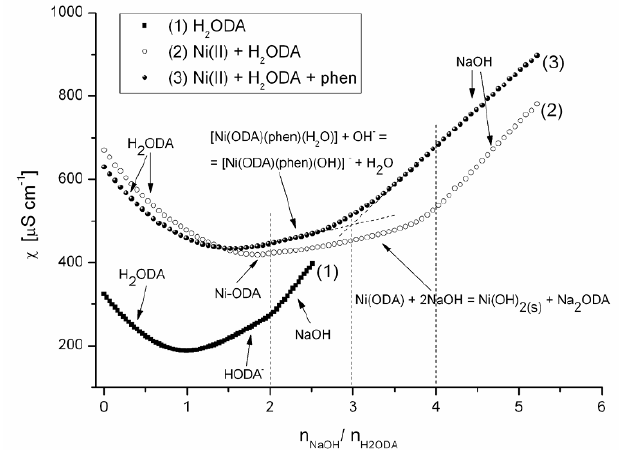
Figure 1. Conductometric titration curves of the H (1.51 mM) + phen (1.48 mM) (3) systems with 25 mM NaOH.